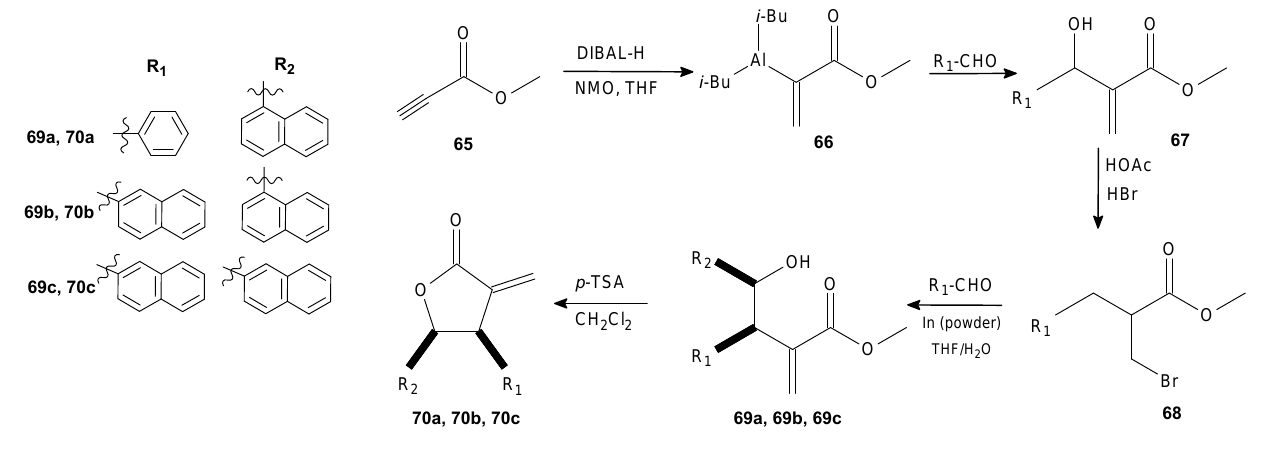
Figure 8. The synthesis of lactones 70a – c .